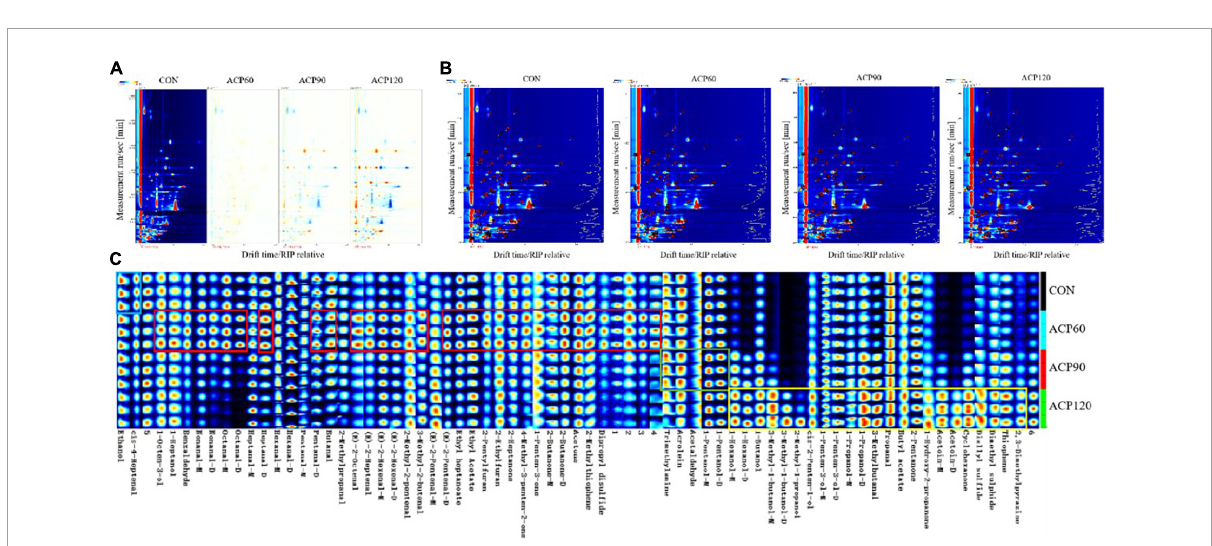
FIGURE5 The analysis of two-dimensional differential map (A) , qualitative map (B) and fingerprint map (C) of surimi gels subjected to different treatment times. (CON, surimi gels without ACP treatment; ACP60, surimi gels treated with ACP for 60 s; ACP90, surimi gels treated with ACP for 90 s; ACP120, surimi gels treated with ACP for 120